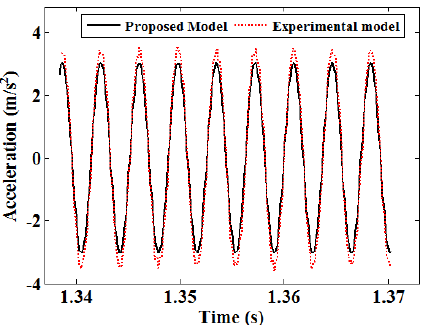
Figure 7. Vibration experimental device of ball screw feed system.